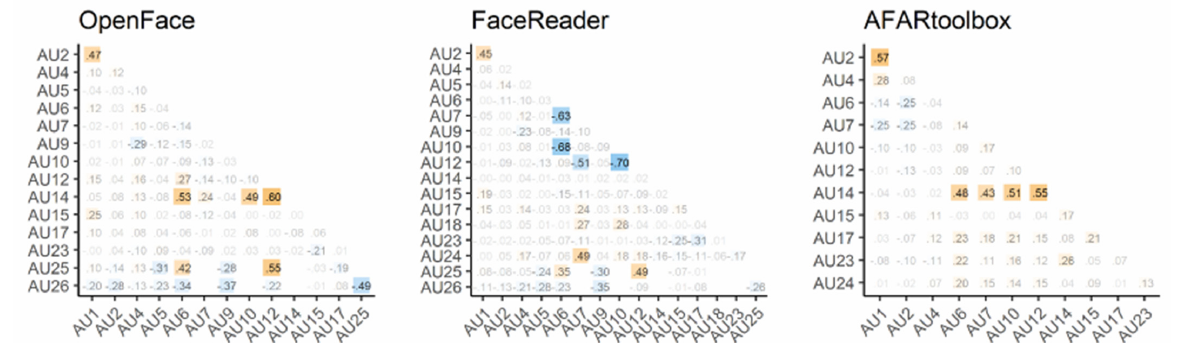
Figure 6. Bias scores of the three automated facial action unit detection systems. If this value is close to 0, the system obtains the same AU co-occurrence rate as the observational data. Positive values (orange squares) indicate biases that predict more AU co-occurrence than the actual data, and negative values (blue squares) indicate biases that fail to capture the co-occurrence relationships in actual facial expressions.